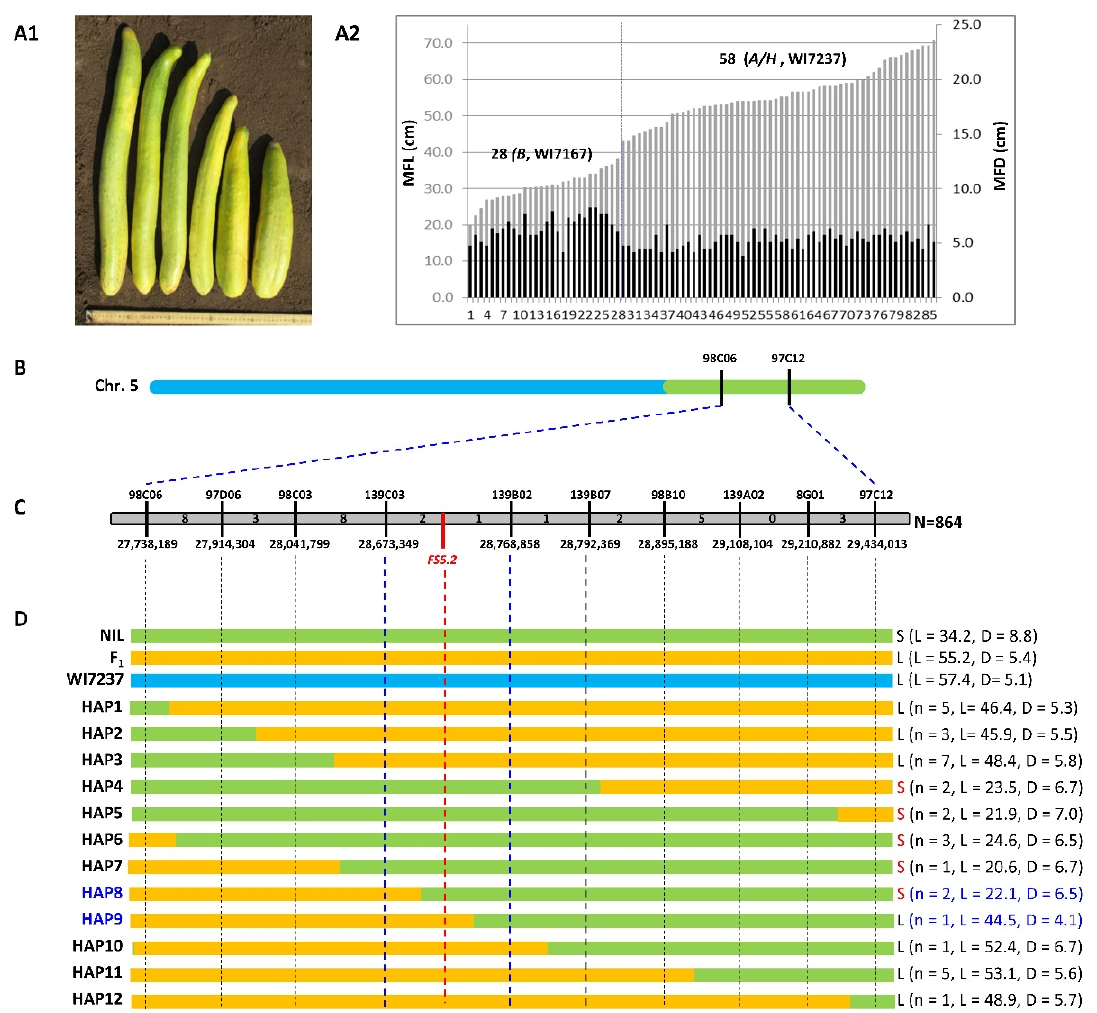
Figure 5. Fine mapping of FS5.2 major-effect QTL. ( A1 ) Representative fruits from NIL-derived F 2 plants showing segregation of fruit size/shape in this population. ( A2 ) Distribution of mature fruit length (MFL) and diameter (MFD) among 82 F 2 plants based on field data. Genotype of each plant at the fs5.2 locus was also shown. ( B – D ) From 864 F 2 plants, 33 recombinants were identified with flanking markers 98C06 and 97C12, which were phenotyped and genotyped with eight additional markers ( C ). Twelve haplotypes (HAP) could be recognized, which allowed mapping of FS5.2 into a 95.5 kb region with 15 predicted genes ( D ). In ( D ), S = short fruit, L = long fruit, and n = # recombinants with the specific haplotype. The light-green, light-blue, and orange bars indicate the genotypes of NIL, WI7237, and F 1 , respectively. L and D are mean fruit length and diameter, respectively, of the haplotype (in